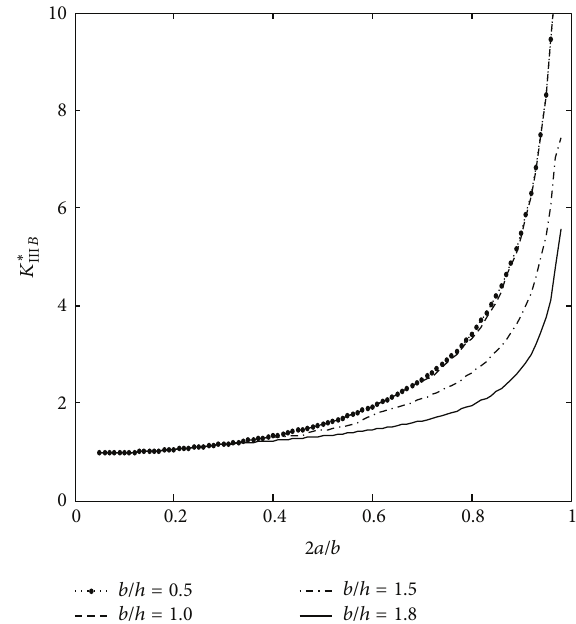
Figure 3: Various SIF of crack-tip 𝐵 with 2𝑎/𝑏 .